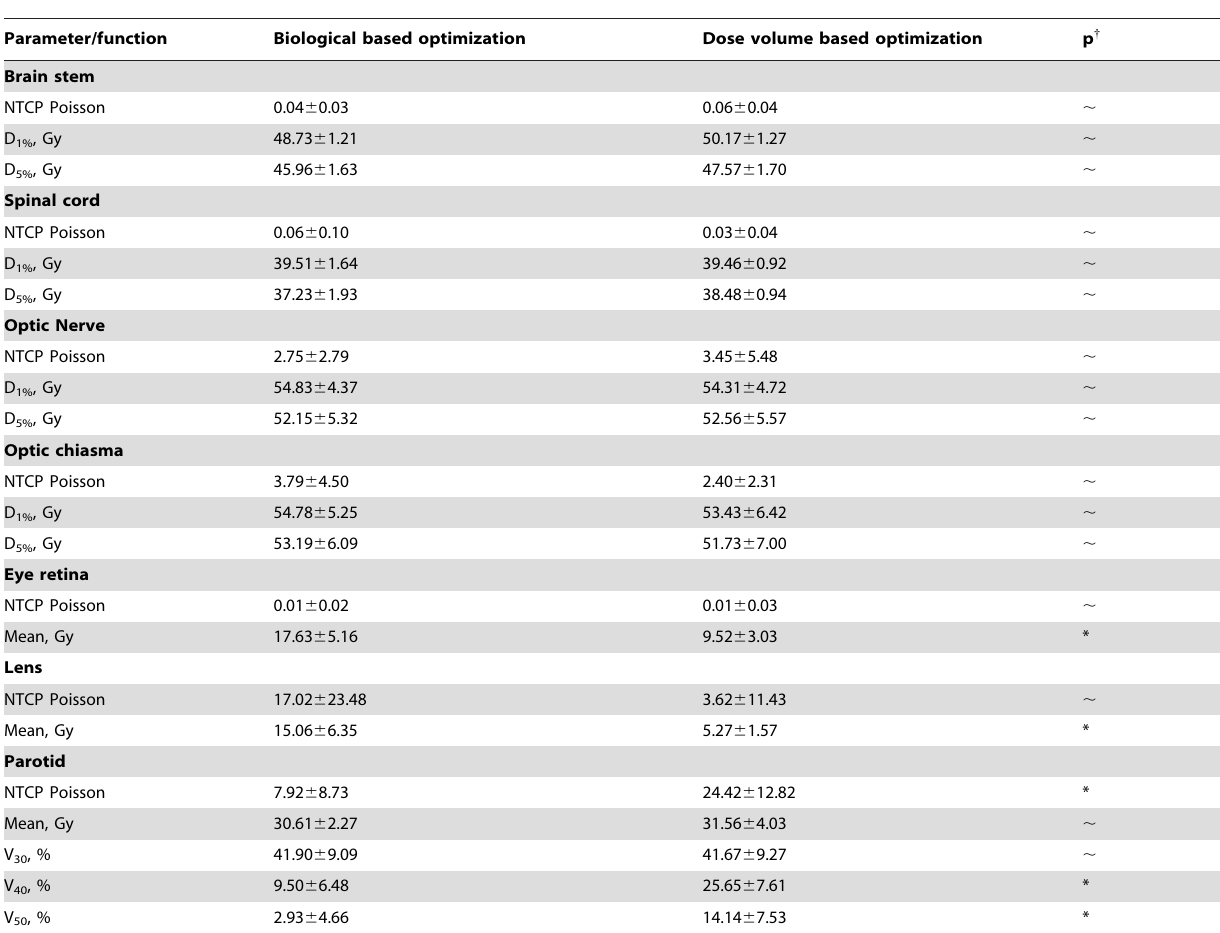
Table 7. Summary of biological and physical evaluation results for OARs averaged over 10 advanced stage NPC